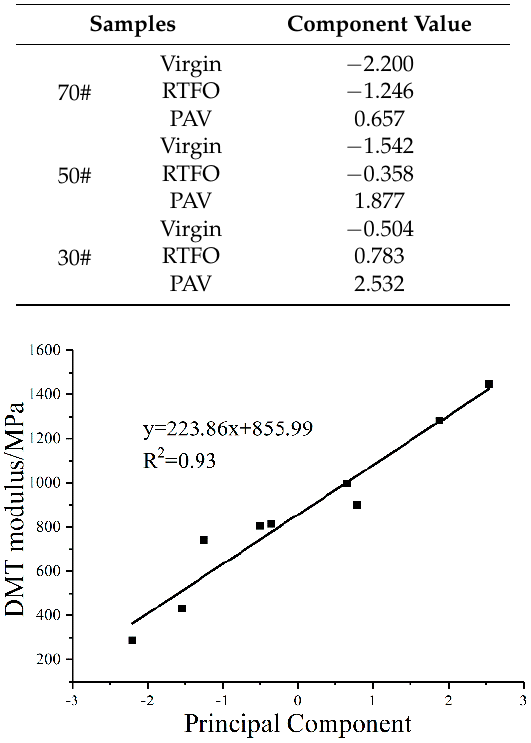
Table 7. Principal components of the chemical functional groups of the bitumen.